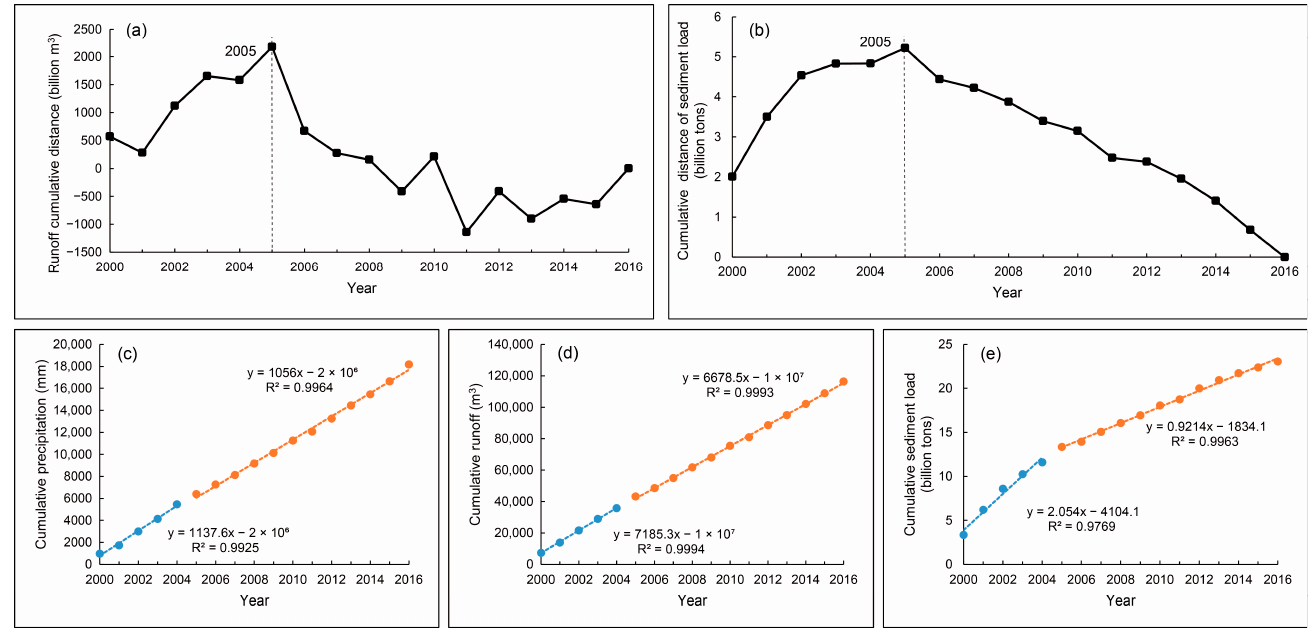
Figure 6. Hankou station: ( a ) Variation characteristics of runoff cumulative distance; ( b ) Variation characteristics of cumulative distance of sediment load; ( c ) Relationship between cumulative pre- cipitation and year; ( d ) Relationship between cumulative runoff and year; ( e ) Relationship between cumulative sediment load and year.